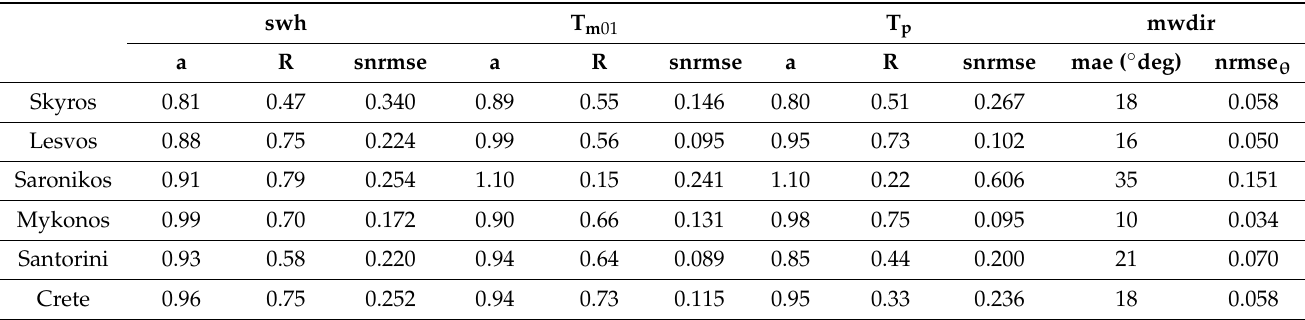
Table 3. SWAN statistical evaluation against buoy measurements from 4 to 7 September 2011. swh T m 01 T p